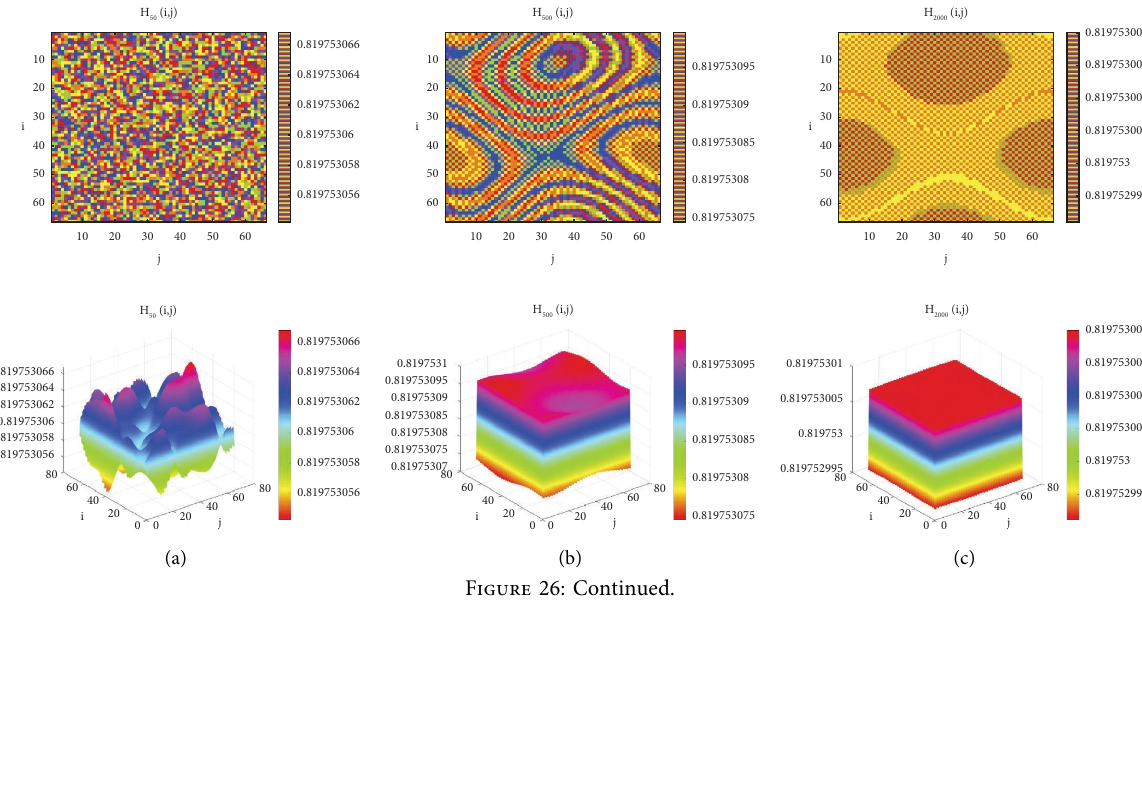
Figure 25: R � 2 , k � 1, c � 0 . 8, σ ∗ � 0 . 278655, σ � σ ∗ , ( d which is consistent with the case of Corollary 3(8), a Neimark-Sacker-Neimark-Sacker bifurcation occurs, parasite and host populations generally exhibit periodic oscillatory behavior.